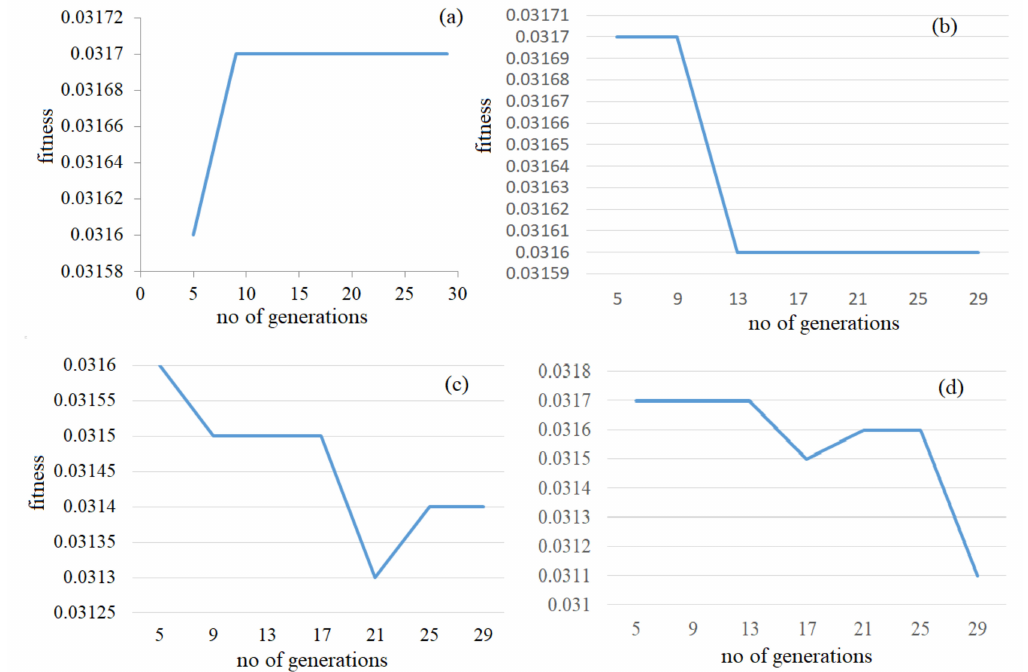
Figure 3. The impact of the number of generations on fitness value in ( a ) single-point/uniform, ( b ) single-point/swap, ( c ) two point/uniform, ( d ) two point /swap